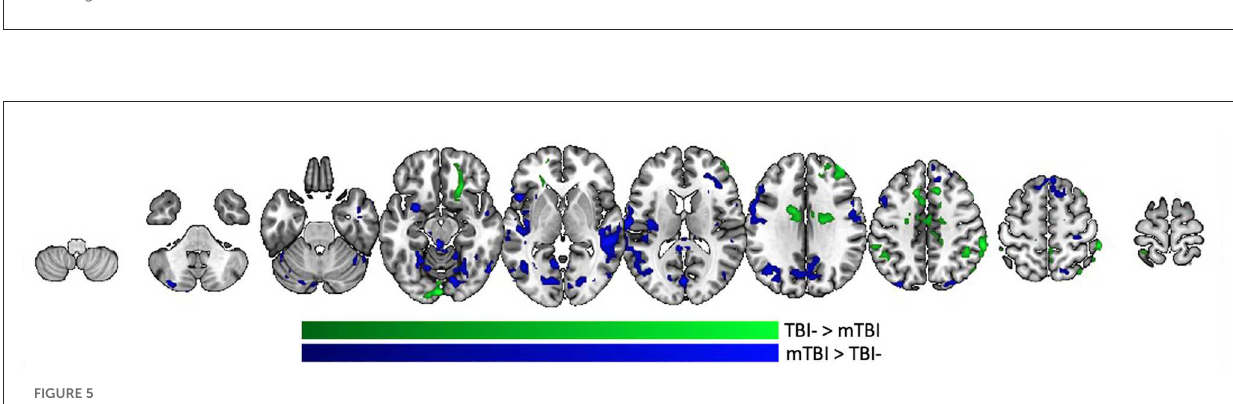
FIGURE4 Amygdala connectivity related to PTS symptom severity score. Voxel-wise connectivity with amygdala correlated with PCL-5 score in (A) the whole group, (B) the TBI- group, and (C) the mTBI group. Warm colors represent regions where the correlation with amygdala is significantly modulated by PCL-5 score in the positive direction; cool colors represent regions where the correlation with amygdala is significantly modulated by PCL-5 score in the negative direction.